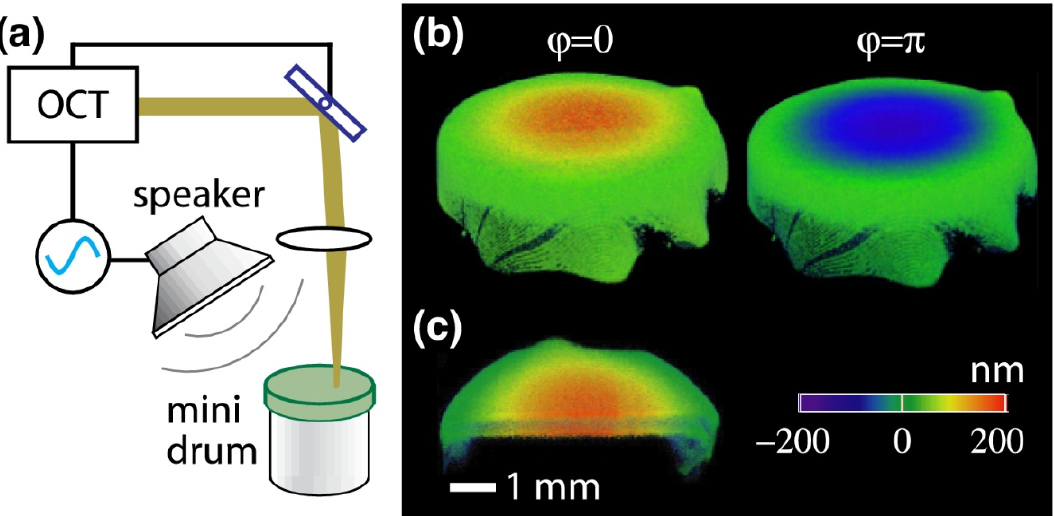
Figure 1. ( a ) Schematic of the setup with a latex drum. ( b ) Vibrography snapshot images (0 and π motion phases) of the vibrating drum at the fundamental frequency of 800 Hz. ( c ) A cutaway image showing the motion in a cross-section of the membrane. Reprinted with permission from Ref. [45]. © The Optical Society.